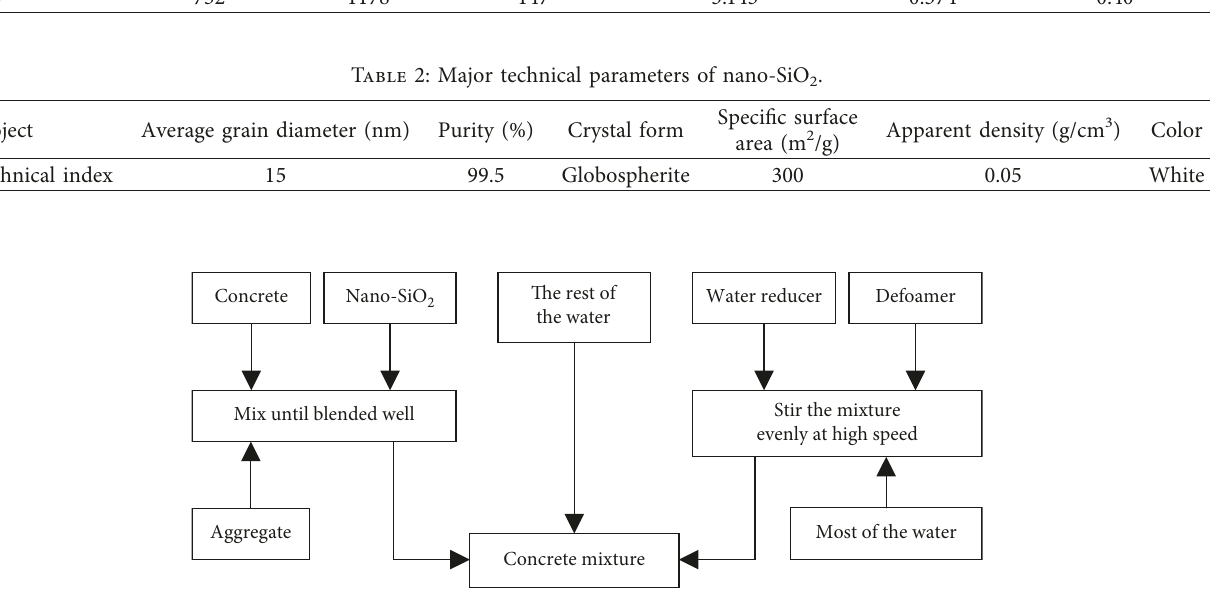
Figure 1: The blending process of SiO